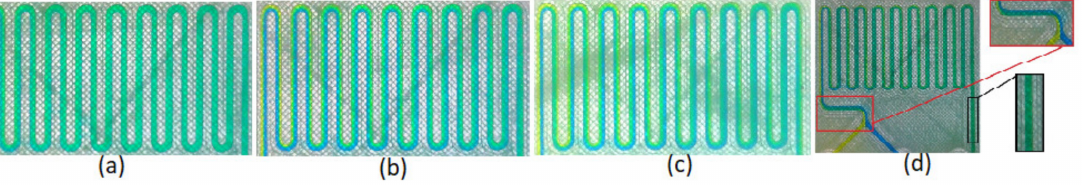
Figure 8. Mixing obtained in FDM micro-mixer. ( a ) flow rate of 10 µ L / min; ( b ) flow rate of 50 µ L / min; ( c ) flow rate of 200 µ L / min; ( d ) flow rate of 400 µ L /